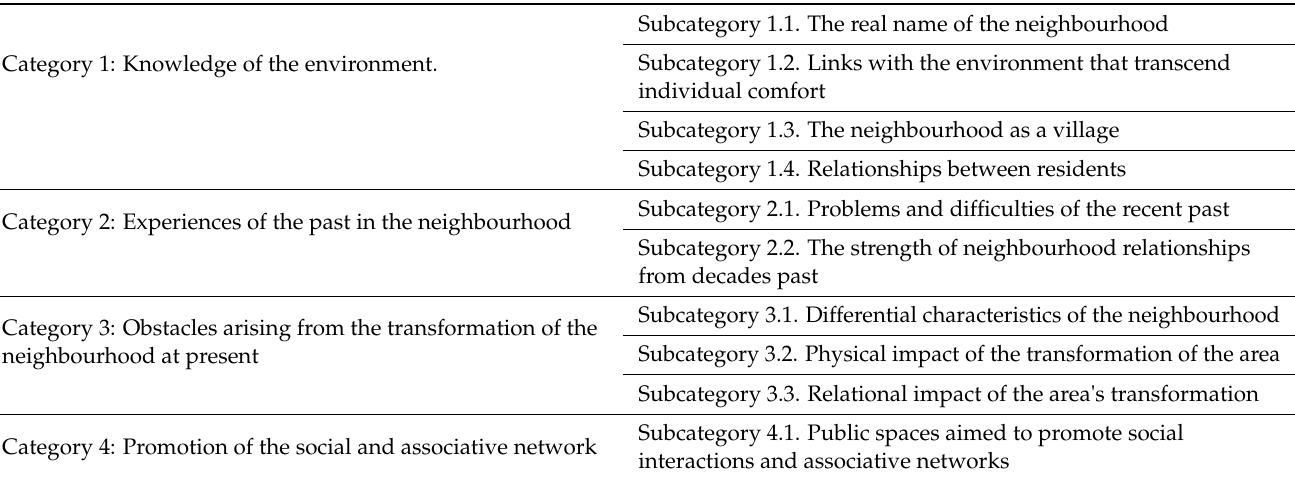
Table 3. Summary of the categories and subcategories obtained from the ethnographic content analysis of the responses of the older women